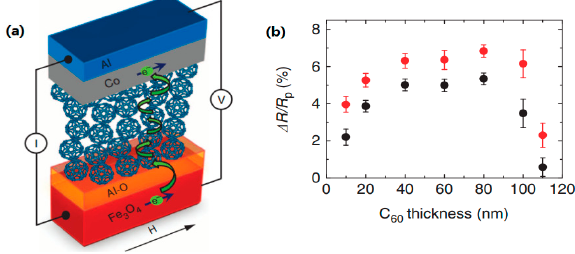
Figure 6. ( a ) A schematic diagram of Fe 3 O 4 /AlO x /C 60 /Co hetorejunction with a MgO substrate (not shown in the diagram). ( b ) Dependence of MR ratio on C60 thickness. The MR was measured at 300 K (black dots) and 150 K (red dots) under a 30 mV bias voltage. The error bars represent a standard deviation of different measured values at each thickness. Adapted from [28], with permission from © 2013 Springer Nature.